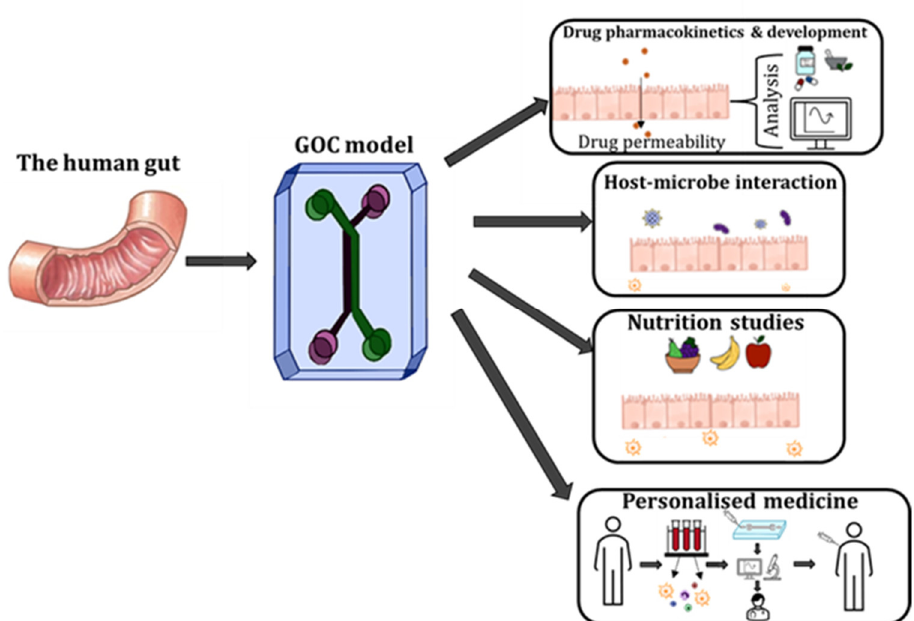
Figure 6. The various applications that GOC models can be utilised, including drug pharmacoki- netics and development, studying host-microbe interactions, nutrition and metabolism studies and personalised medicine.